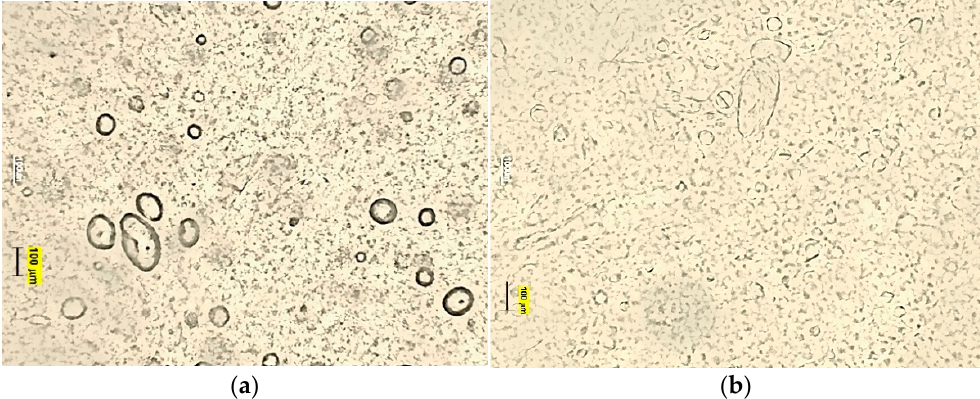
Figure 5. Microscopic image of a cream with methyl silicone oil, sample E1, magnification ( a ) 10×, ( b ) 40×.